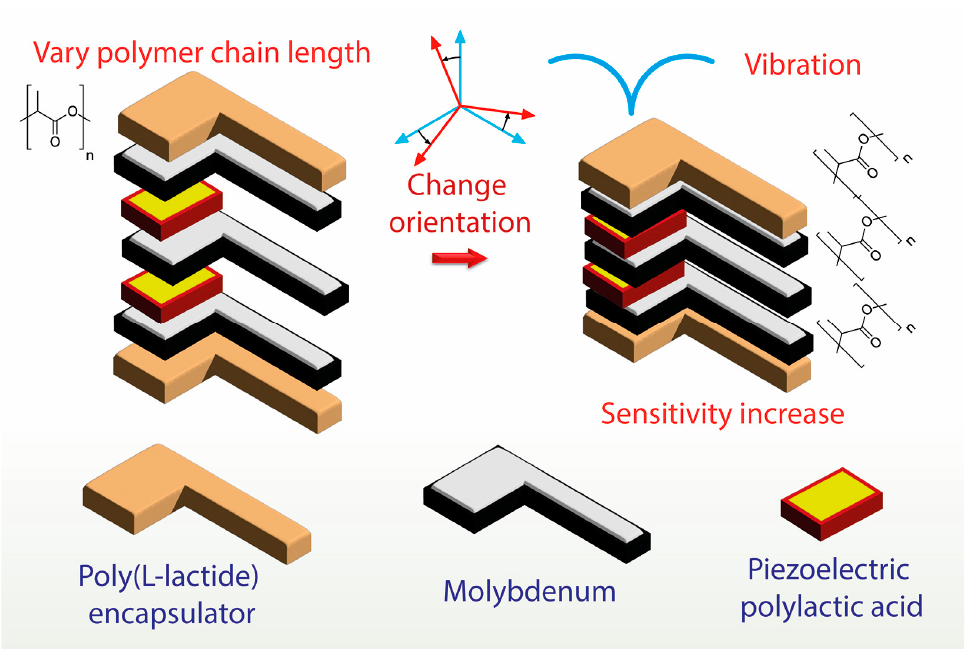
Figure 2. Biodegradable piezoelectric Poly(L-lactide) (PLLA) sensor to monitor pressure of diaphragmatic contraction in animal subjects.